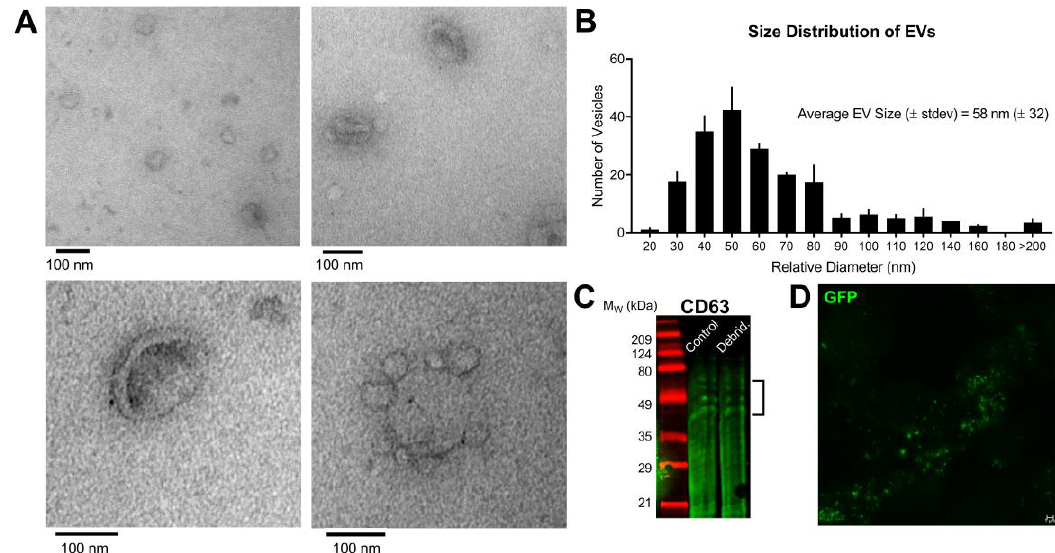
Figure 1. Relative morphology and size of EVs collected from hCE-TJ-conditioned medium. ( A ) TEM images of isolated EVs show the characteristic cup-shaped morphology of fixed EVs. Low-magnification ( top left panel ) and high-magnification ( top right and bottom panels ) show differential size ranges from 30 – 100 nm. ( B ) Size distribution of isolated EVs based on the relative diameter assessed by TEM. Data based on n = 3 independent EV preparations. Error bars represent the standard error of the mean (SEM). ( C ) CD63 protein expression in EVs isolated from conditioned medium of control and debrided hCE-TJ cell layers analyzed by Western blot under non-reducing conditions (predicted molecular weight of 30 – 60 kDa [42,45]). ( D ) Stimulated emission depletion (STED) microscopy of isolated GFP-hCE-TJ-derived EVs imaged under a 100× oil-immersion objective lens. Scale bar represents 1 μm.